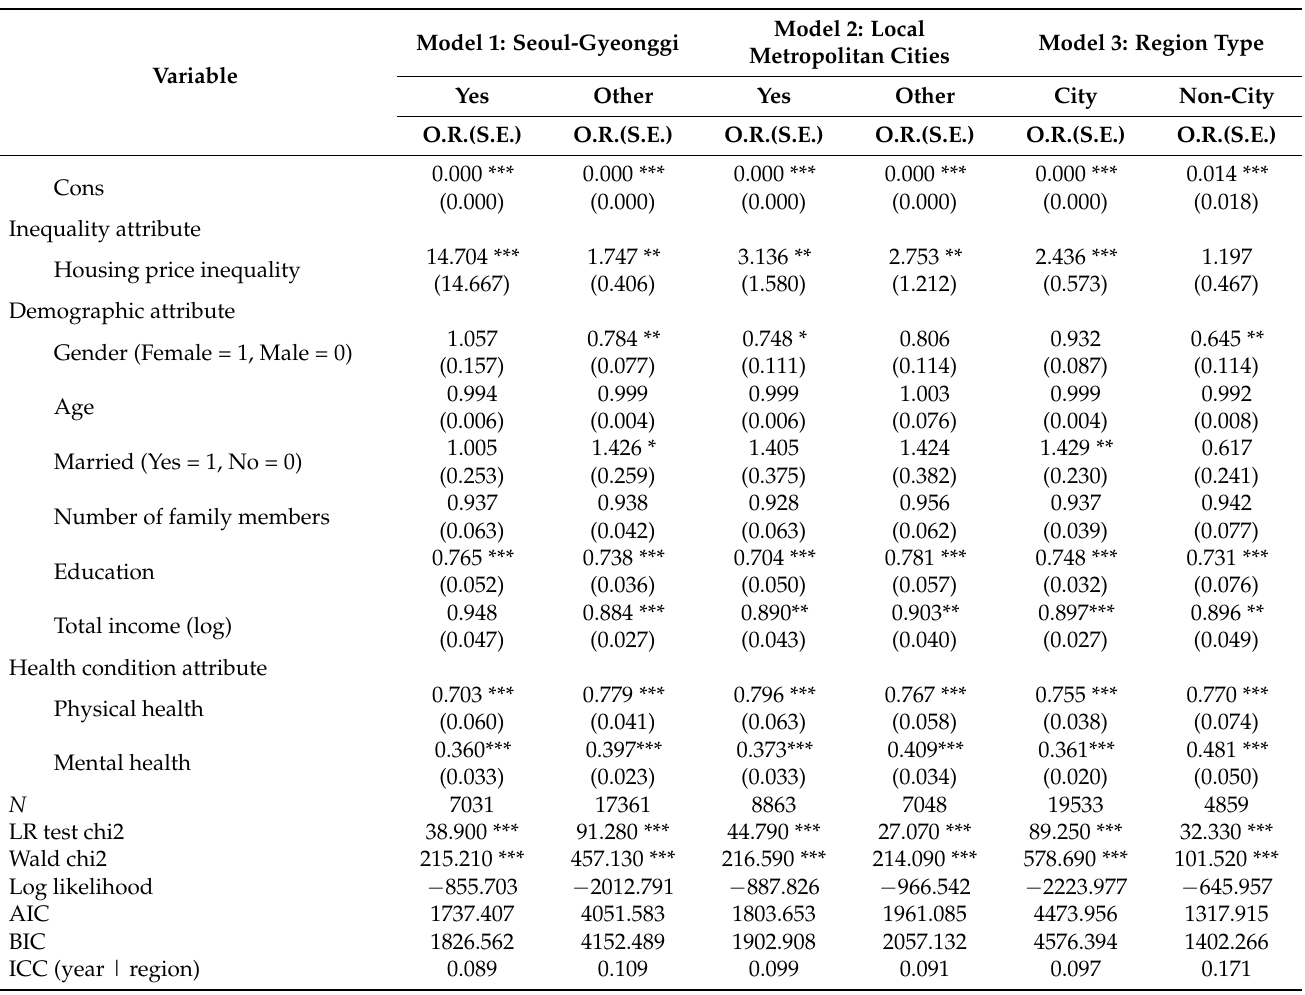
Table 4. Results for regression analysis by regional